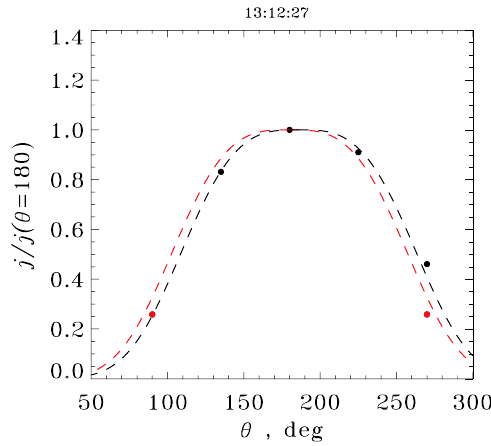
Fig. 13. Currents measured by SLP in the night sector at − 50 ◦ magnetic latitude in the conditions λ D ≈ 2cm, T ≈ 0 . 15 eV , eϕ =− 20 kT . Black and red dots stand for the currents measured in the plan xoy and xoz, respectively. Currents are normalized to the current recorded by the segment located at 180 ◦ . The red dashed line is the same as that which is presented in the Fig. 11a, the black dashed line is the same as the red one but is shifted along θ -axis by 6 ◦